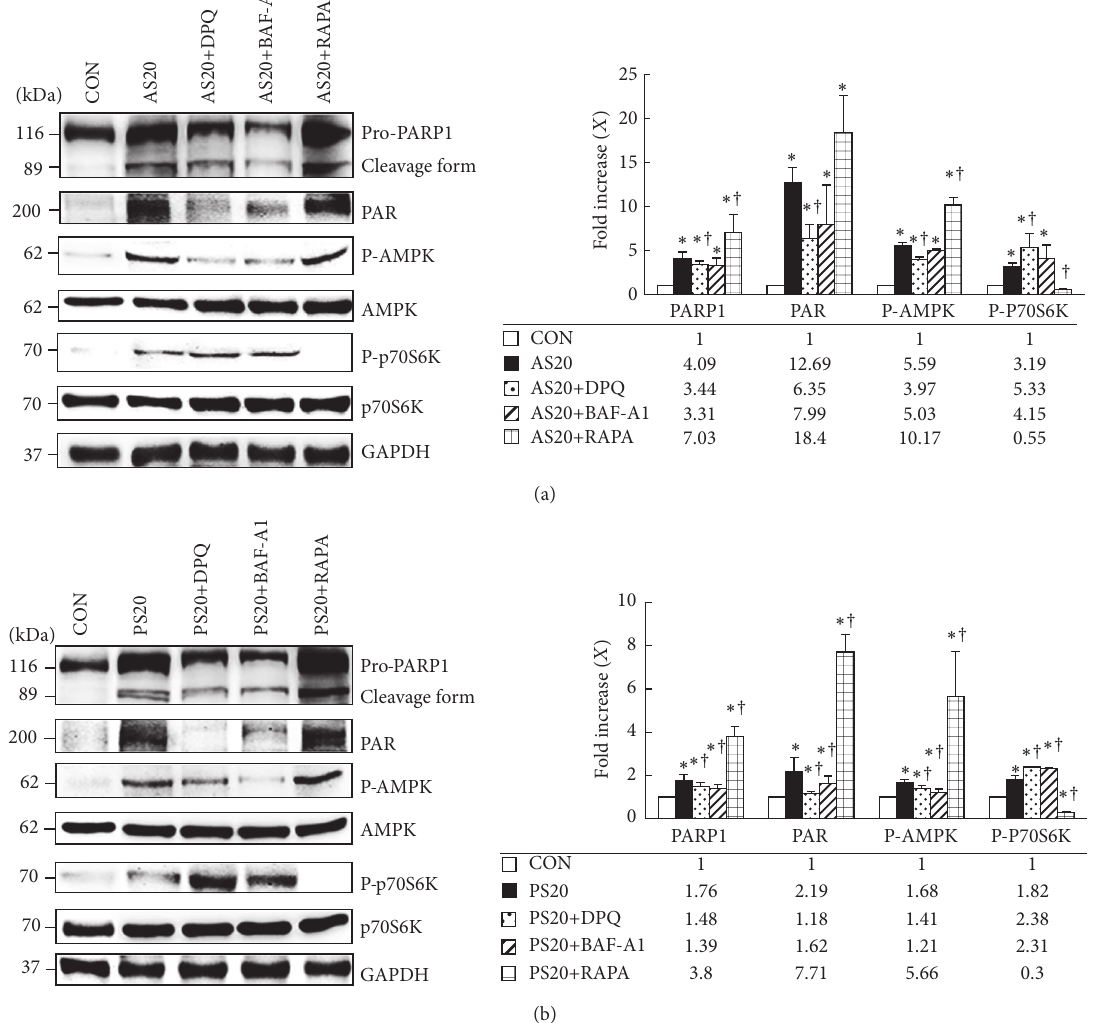
Figure 6: Suppression of PARP1 inhibits AS-mediated necrosis and AS-induced cell death. (a) NIT-1 cells cultured with AS treatment exhibited dependent activation of PARP1, PAR, and AMPK and reduced phosphorylated p70S6K compared with BAF-A1 negative autophagy control; the expression was reduced considerably compared to RAPA positive autophagy control. DPQ (PARP1 inhibitor) blocked AS- mediated PARP1, PAR, and AMPK upregulation. BAF-A1 markedly induced P-p70S6K formation; RAPA almost completely eliminated P- p70S6K. (b) PS treatment caused the significant upregulation of PARP1, PAR, and AMPK phosphorylation but a downregulation of p70S6K phosphorylation.DPQsignificantlyblockedPS-mediatedPARP1,PAR,andAMPKupregulation.BAF-A1alsodidmarkedlychangeP-p70S6K formation; RAPA almost completely eliminated P-p70S6K ( ∗ 𝑃 < 0.05 , compared to the untreated group; † 𝑃 < 0.05 , compared to the only AS- or PS-treated group; mean ± SD from three